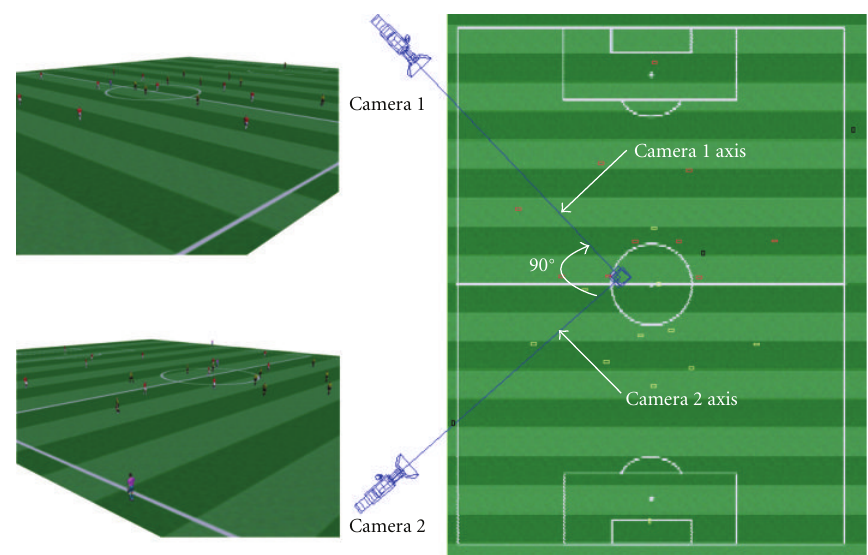
Figure 7: The ideal positioning of a couple of cameras. The two cameras’ axes are perpendicular in top